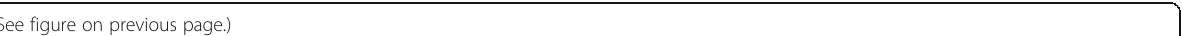
Planktonic larval stages (Fig. 4; Fig. 5; Fig. 6) 3.0 – 4.3 mm TL (Fig. 4a; Fig. 5a-c; Additional file 3: Figure S2A) The size of larvae artificially induced to hatch ranged from 3.0 to 4.3 mm TL (Additional file 3: Figure S2A). The larva at this stage has a round head, a continuous median fin fold, and a yolk sac (Additional file 3: Figure S2A). The endoskeletal disc (ed) and the apical fin fold (af) are located at the proximal and distal regions of the pectoral fin bud, respectively (Fig. 4a). A thin zone of matrix decomposition (mdz) is seen in the center of the endoskeletal disc of the pectoral fin (Fig. 5a). At the proximal part of the endoskeletal disc, cells are more rounded, and small numbers of dividing cells are noticeable (Fig. 5b). At the distal part of the endoskeletal